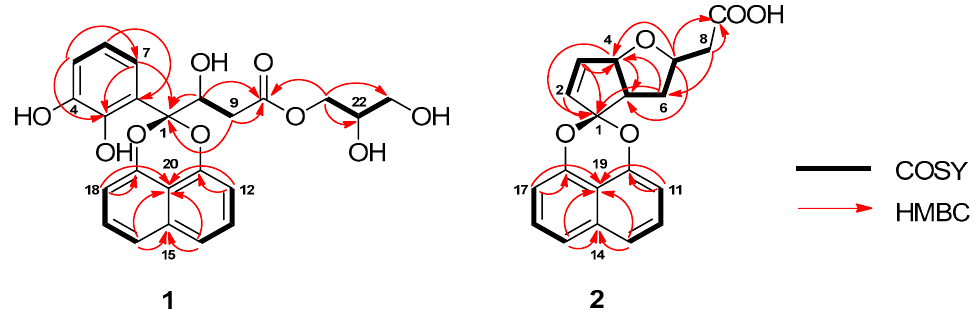
Figure 2. COSY and HMBC correlations in 1 and